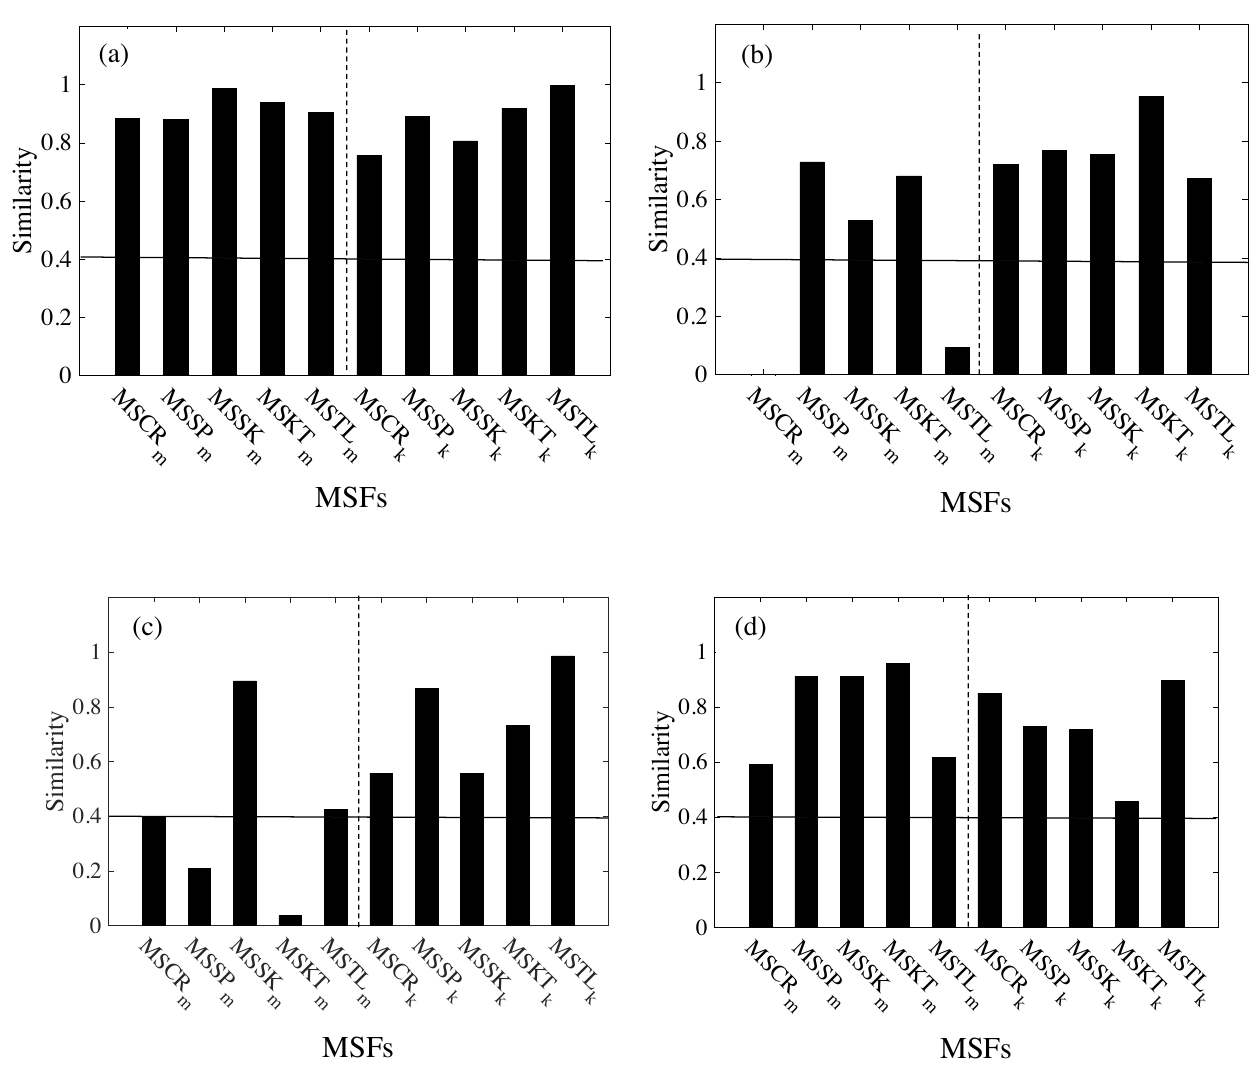
Figure 9. Highest similarity of each MSF in clean/noisy/reverberant/noisy reverberant environ- ments: ( a ) clean environment [15], ( b ) noisy environment (SNR = 5 dB), ( c ) reverberant environment ( T R = 1.0 s), and ( d ) noisy reverberant environment (SNR = 10 dB, T R = 0.5